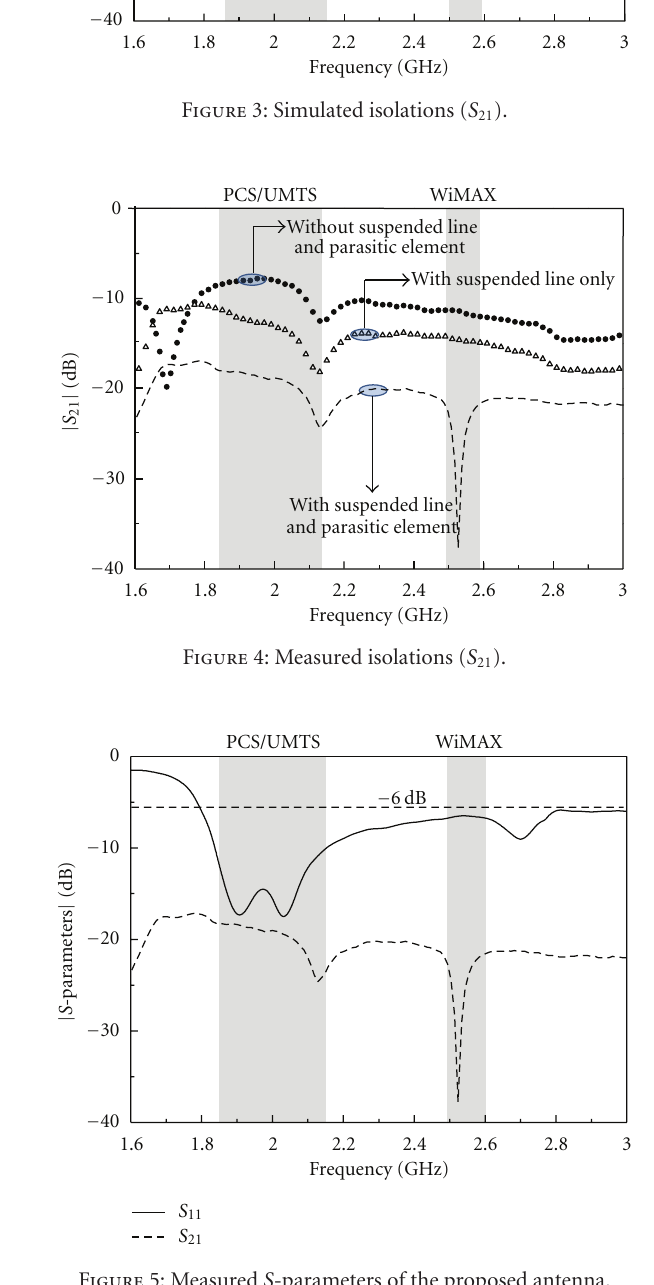
Figure 5: Measured S -parameters of the proposed